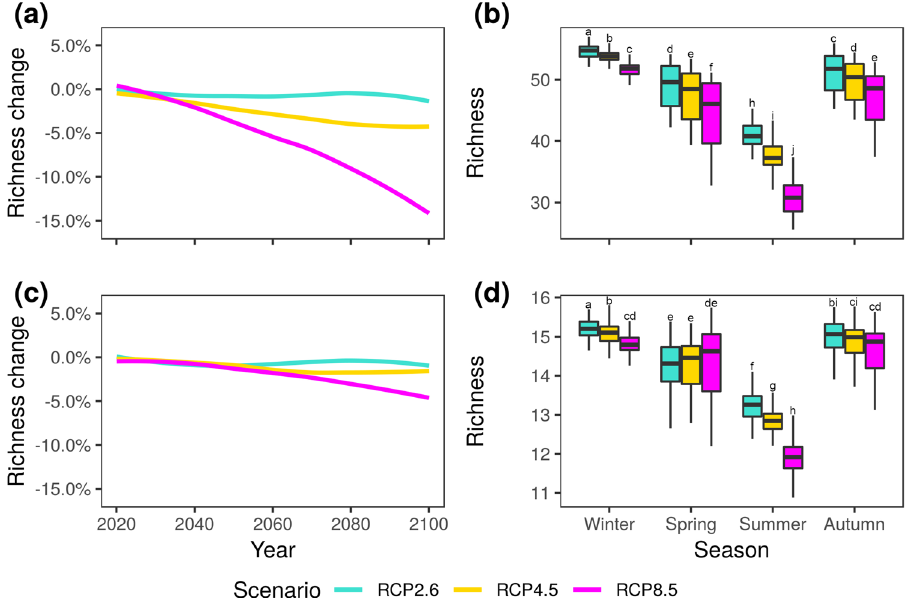
Figure 3. Richness trends and seasonal predictions for plant and human putative eukaryal pathogens. ( a ) Richness change for plant pathogens. ( b ) Seasonal prediction for plant pathogens in 2081–2100. ( c ) Richness change for human pathogens. ( d ) Seasonal prediction for human pathogens in 2081–2100. Letters indicate between-group differences based on post-hoc